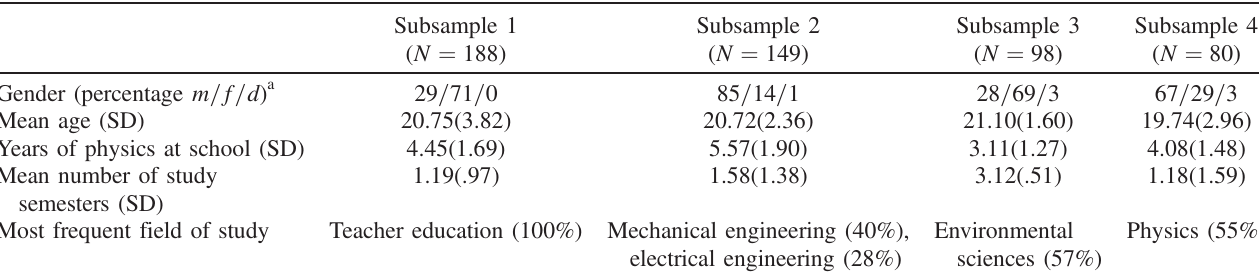
TABLE III. Information of